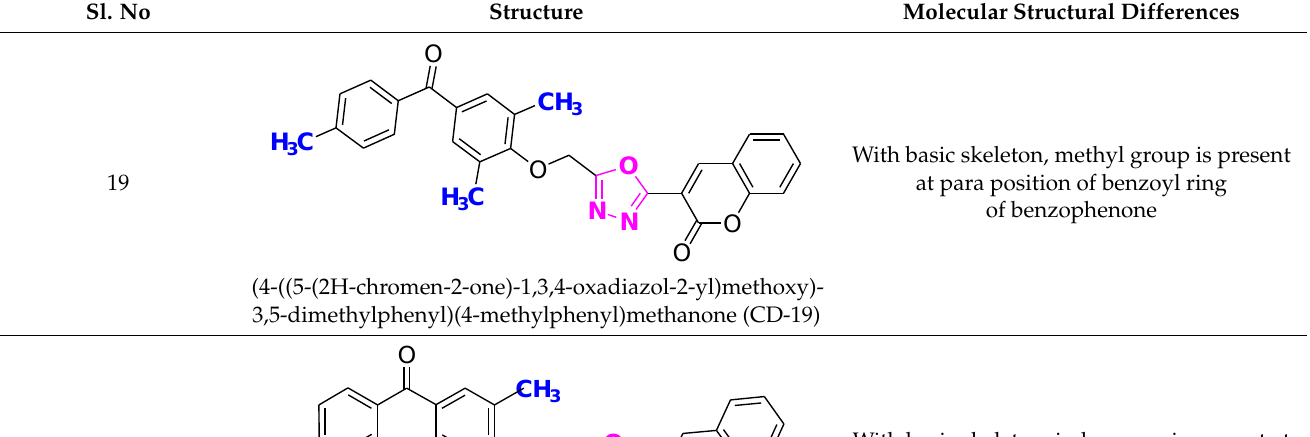
With basic skeleton, iodo group is present at para position of benzoyl ring of